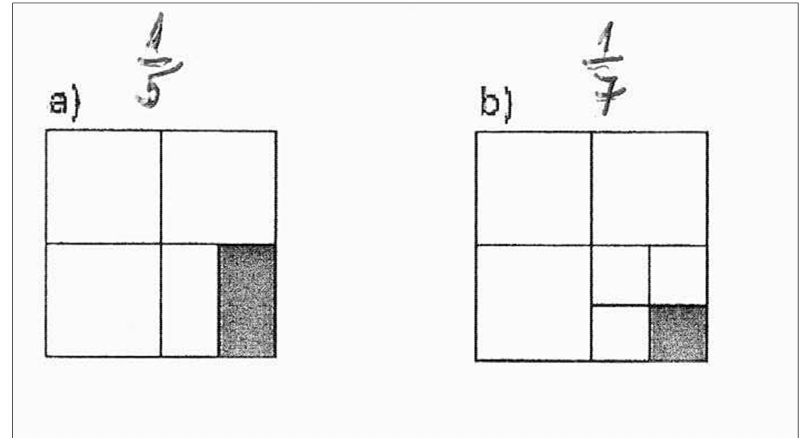
Figure 7. Incorrect solution 1.